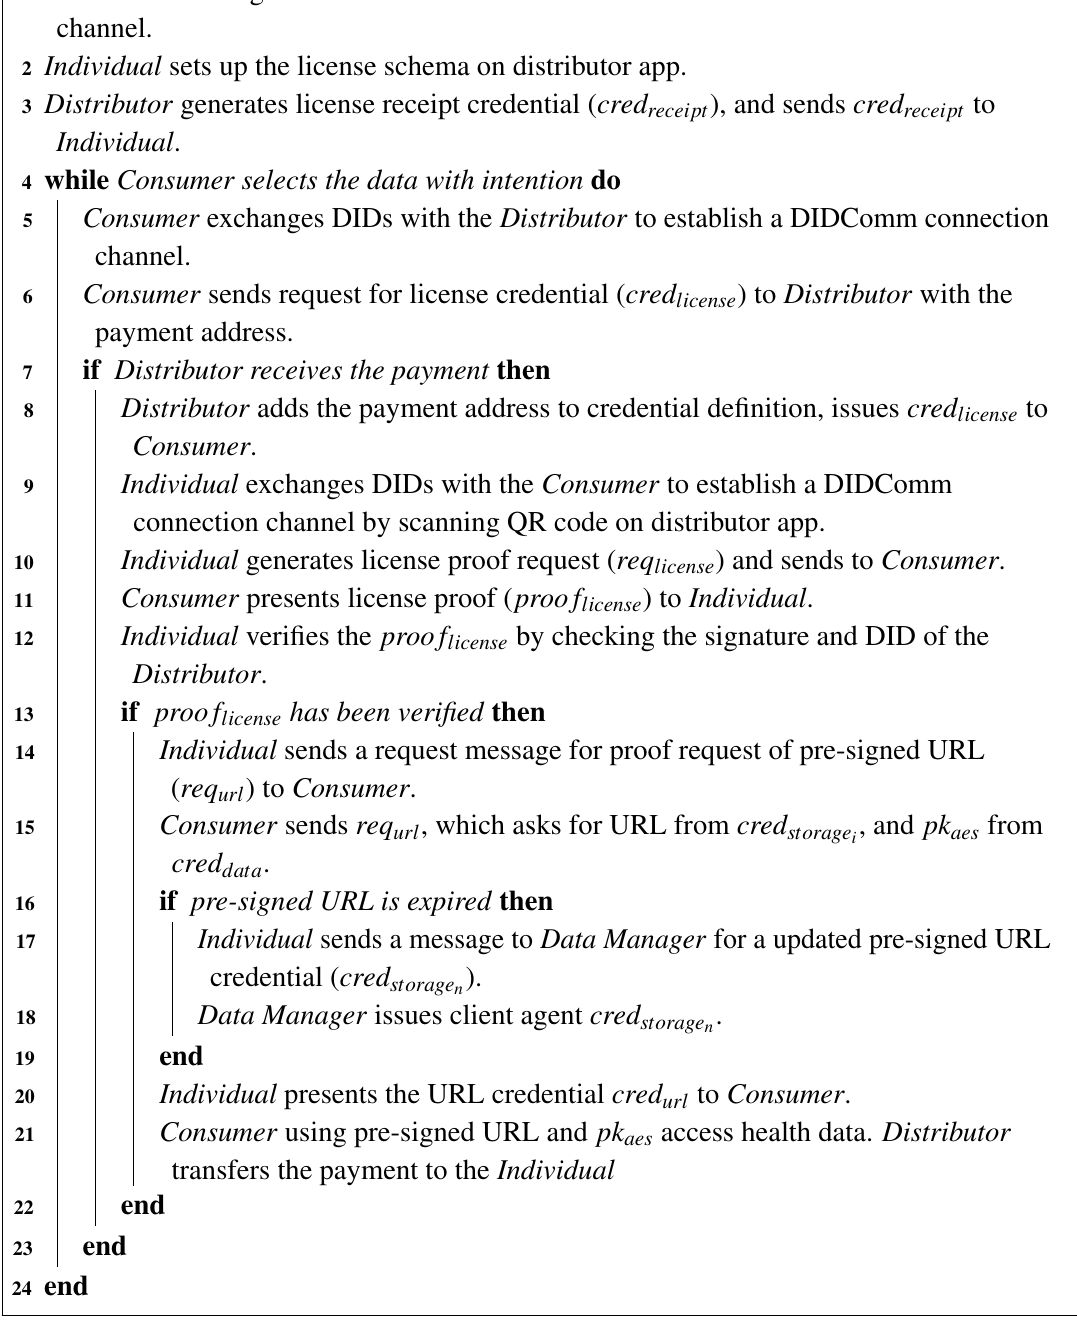
Algorithm 3: Data Licensing and